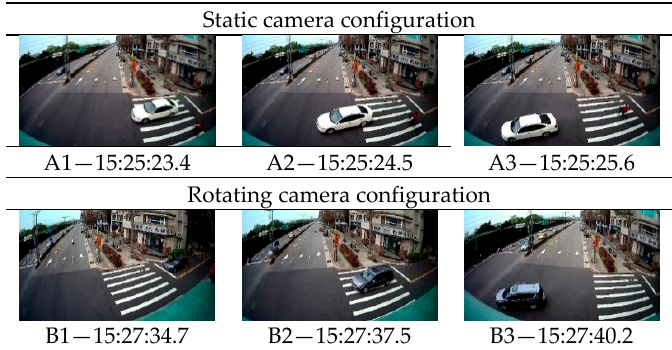
Figure 9. A fraction of the street-view image sequence.